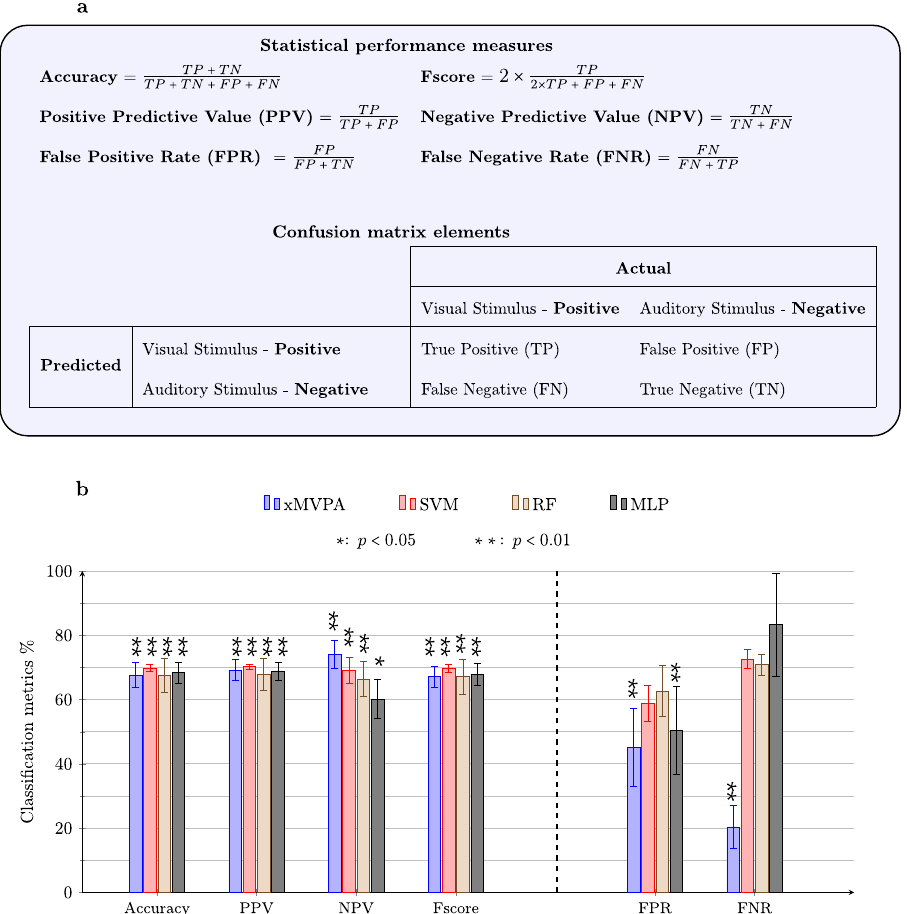
Fig. 3 Comparison of statistical performance measures of xMVPA with black-box models. a De fi nition of the statistical performance measures used for comparison of frameworks prowess in driving MVPA. A confusion matrix of binary classi fi cation problem, i.e., predicting one of the two stimuli (Visual or Auditory) that best matches the brain activity instances. The visual stimulus is referred to as the positive stimulus and the auditory stimulus as the negative stimulus. b A bar chart for the comparison of frameworks driving MVPA including the proposed model xMVPA, Support Vector Machines (SVM), Random Forest (RF), and Multi-Layer Perceptron (MLP) on infant ’ s unisensory fNIRS dataset. PPV: predictive positive value; NPV: negative predictive value; FPR: false positive rate; FNR: false negative rate with error bars representing the standard deviation. The statistical performance measures that attain statistical signi fi cance over the decoding results of a baseline classi fi er with 5,000 randomly permuted stimulus labels are denoted with asterisks (*). A breakdown of the values and statistics in this fi gure is detailed in Supplementary Table